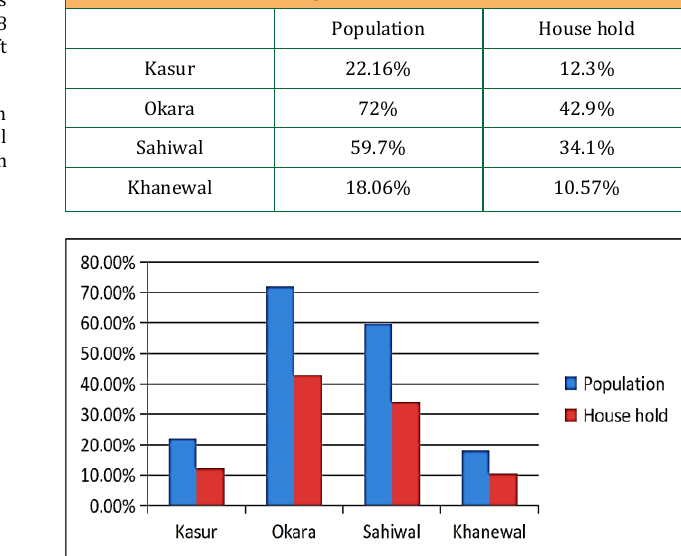
Figure 1(a): Command Area of LBDC Figure 1(b): Population at the command area of LBDC Table 2: Agricultural Area covered the command area of LBDC